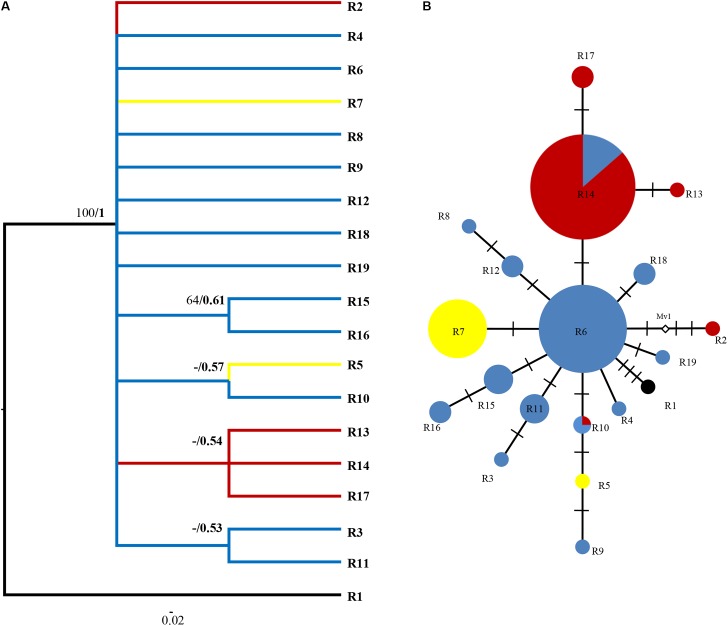
Phylogenetic relationships based on ITS ribotypes. (A) The Bayesian tree of the 19 ITS ribotypes detected in R. fastigiata. Numbers above the branches are MP bootstrap support values (left) and Bayesian posterior probability (right). R1 represents outgroup sequence of R. coccinea. (B) NETWORK-derived genealogic relationships. The size of the circles in the network is proportional to the observed frequencies of the haplotypes in each population. The white diamonds represent missing ribotypes. Different color of circles represents geographic groups defined by the SAMOVA analysis.